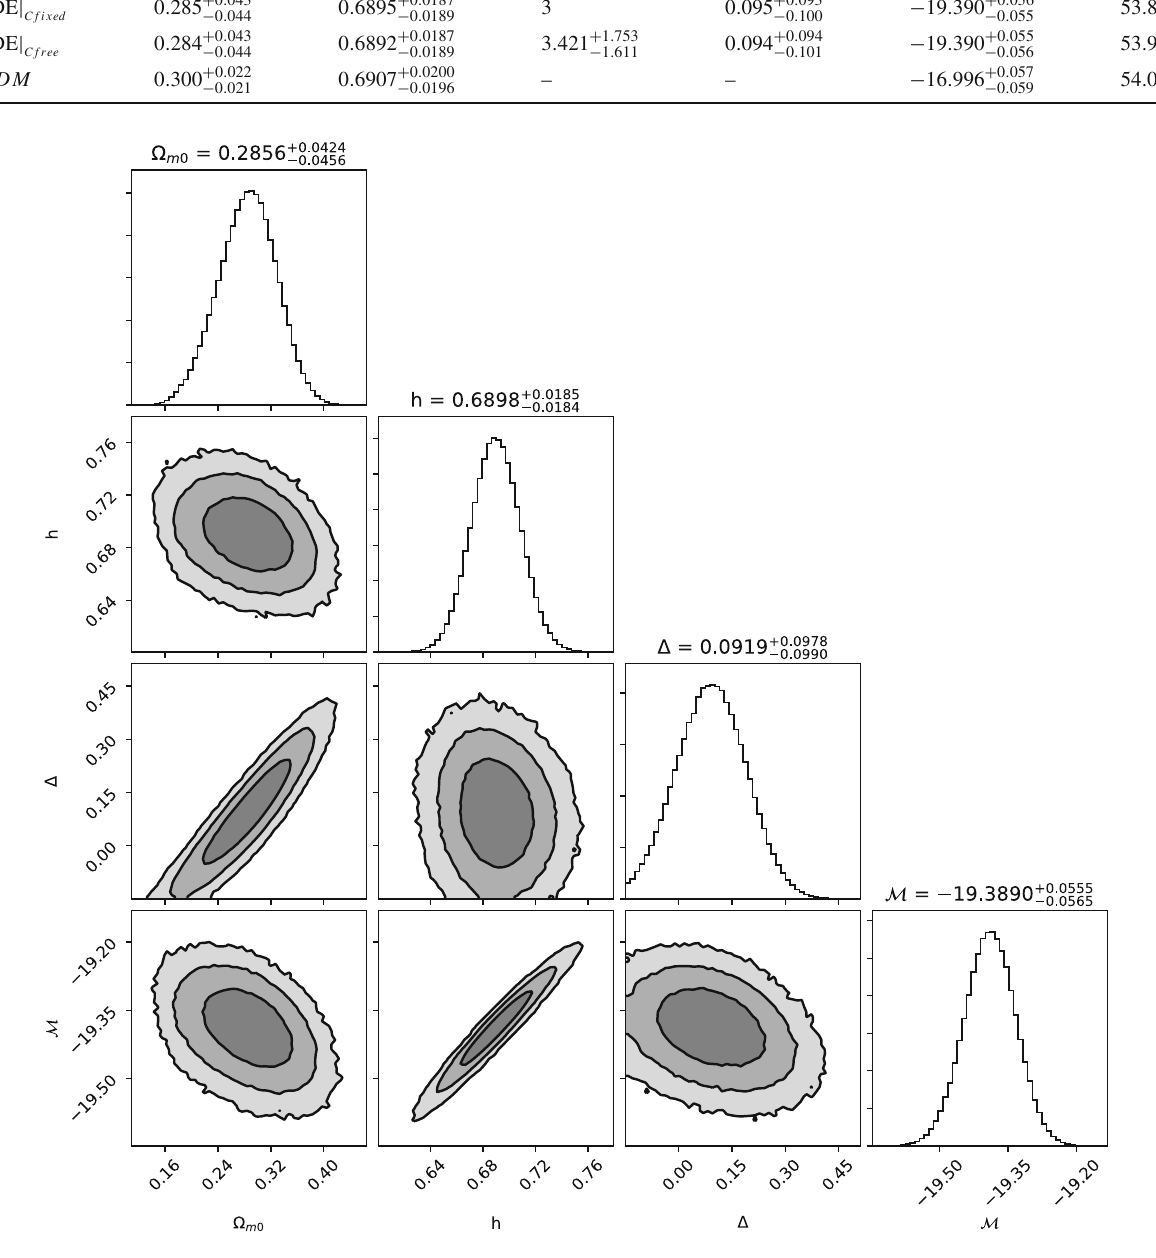
Fig. 1 The 1 σ , 2 σ and 3 σ likelihood contours for Barrow holographic dark energy, in the case where we fix the model parameter C = 3 in M p units, using SNIa and H ( z ) data. Additionally, we present the involved 1-dimensional (1D) marginalized posterior distributions and